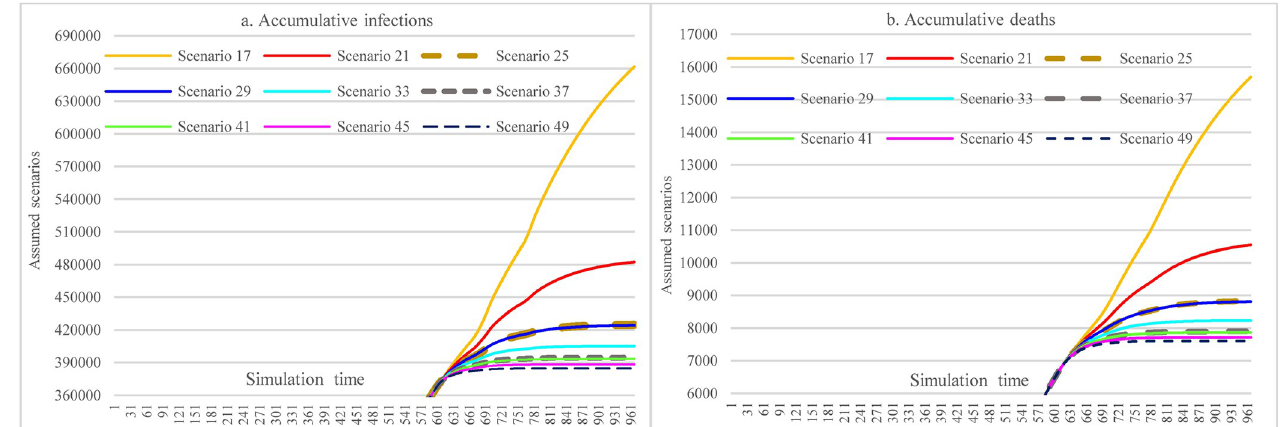
Fig 16. Offsetting less stringent social distancing measures with increasing mask-wearing adherence level.